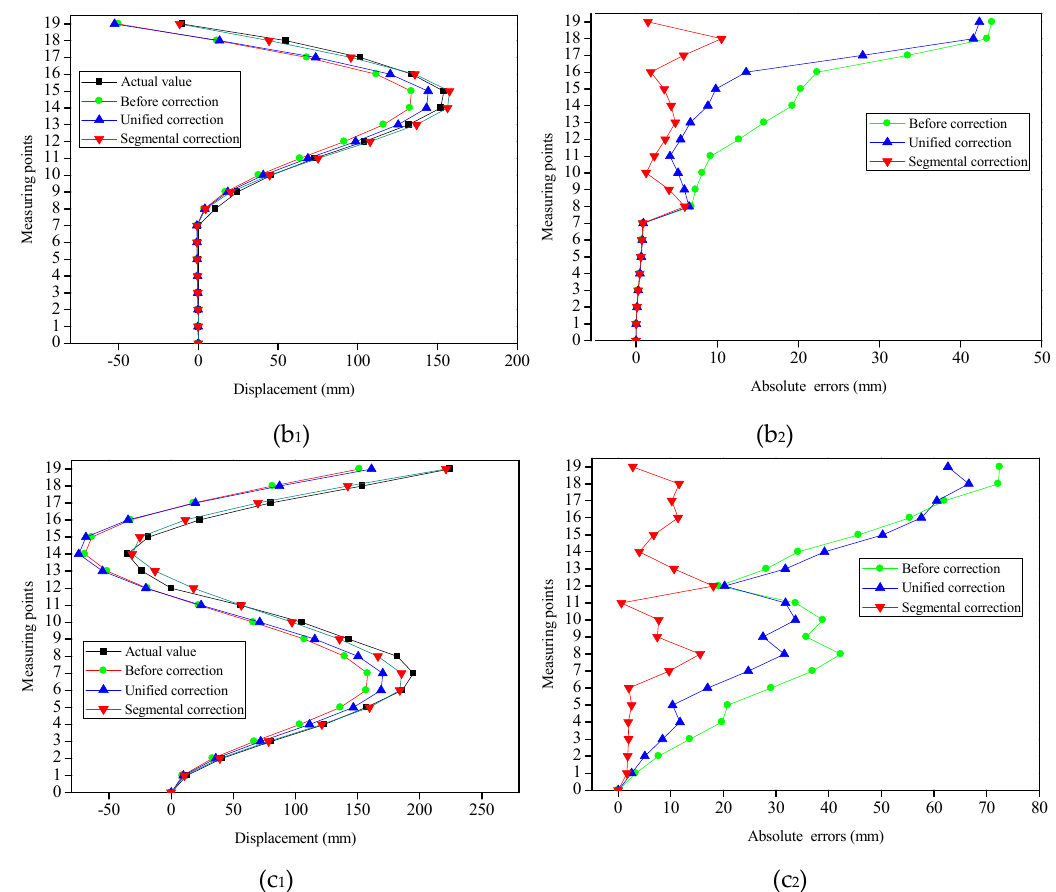
Figure 13. Demonstration of the experimental results under three bending shapes of the FBG flexible sensor. ( a 1 ), ( b 1 ) and ( c 1 ) represented the displacements contrast of the measuring points for Type 1, Type 2 and Type 3, respectively. ( a 2 ), ( b 2 ) and ( c 2 ) represented the absolute errors contrast of the measuring points for Type 1, Type 2 and Type 3, respectively.